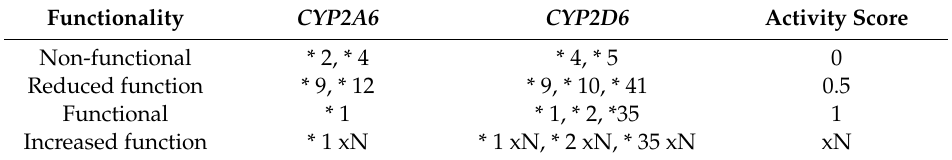
Table 2. Activity scores assigned to the presence of CYP2A6 and CYP2D6 alleles. Functionality CYP2A6 CYP2D6 Activity Score